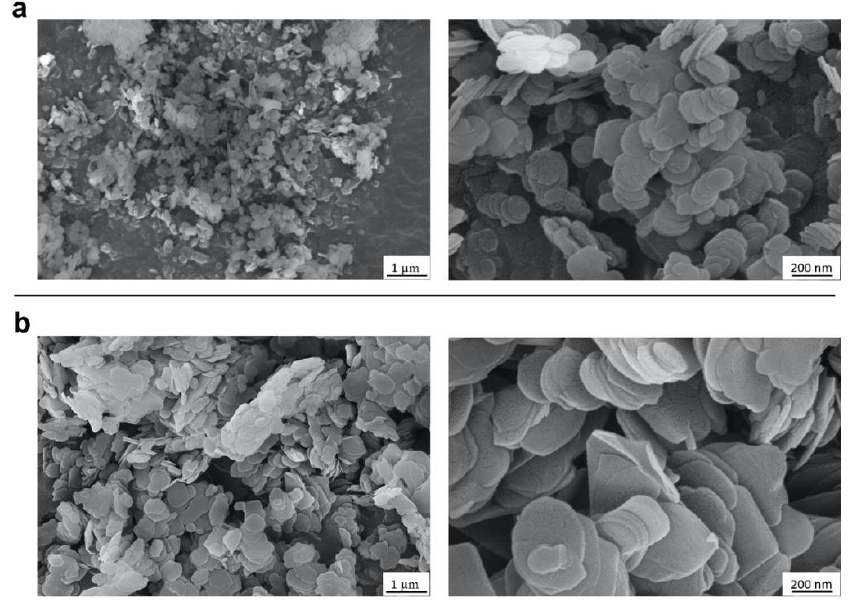
Figure 2. FE-SEM images of BN nanopowder ( a ) and BN nanoplatelets ( b ). Minute quantities of both samples were directly dropped on carbon tape.